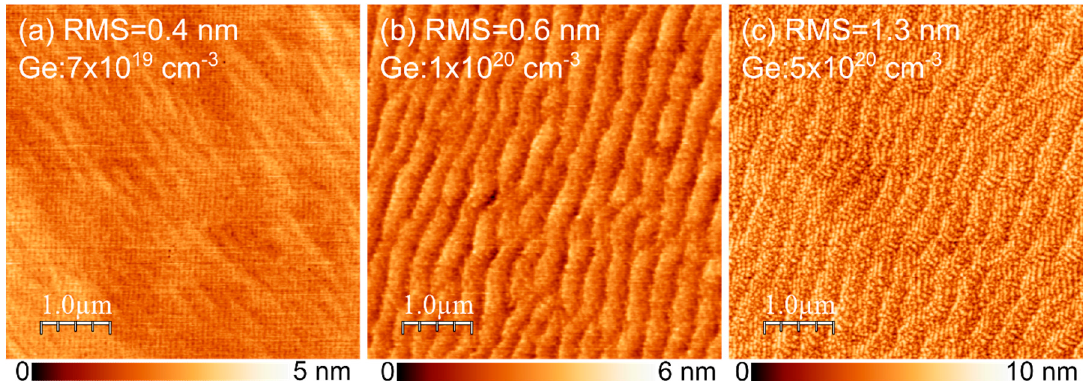
Figure 6. InGaN:Ge surface obtained by AFM for 30 nm-thick layers with Ge concentration tuned between 7 × 10 19 atoms/cm 3 and 5 × 10 20 atoms/cm 3 . Corresponding root mean square (RMS) values and concentrations are indicated on each